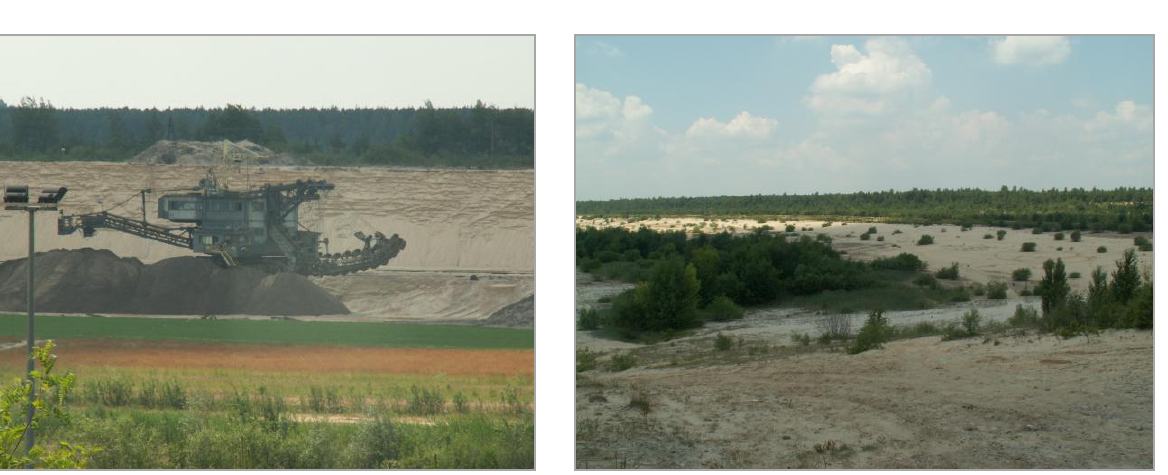
Fig. 3. Active sandpit in Biskupi Bór near Bukowno ( J. Pełka-Gościniak, June 2010 )